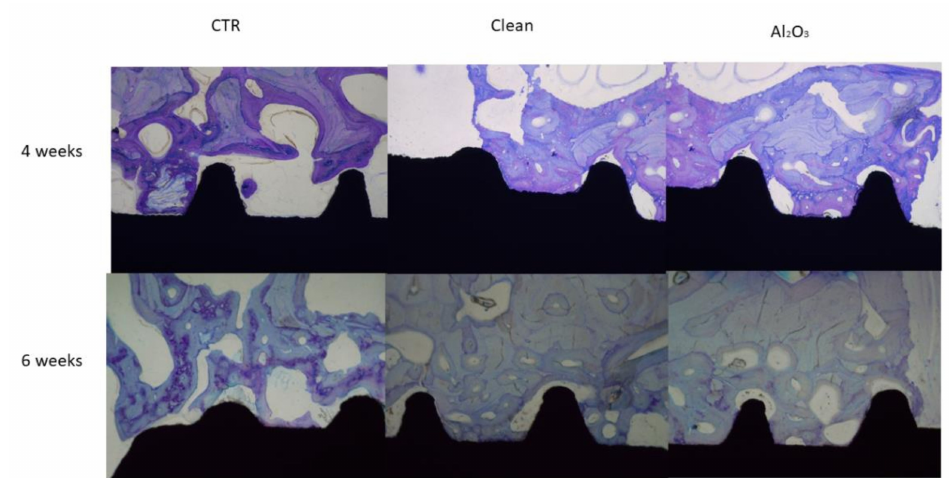
Figure 6. Histologies of the dental implants after 4 and 6 weeks of implantation for the three surfaces